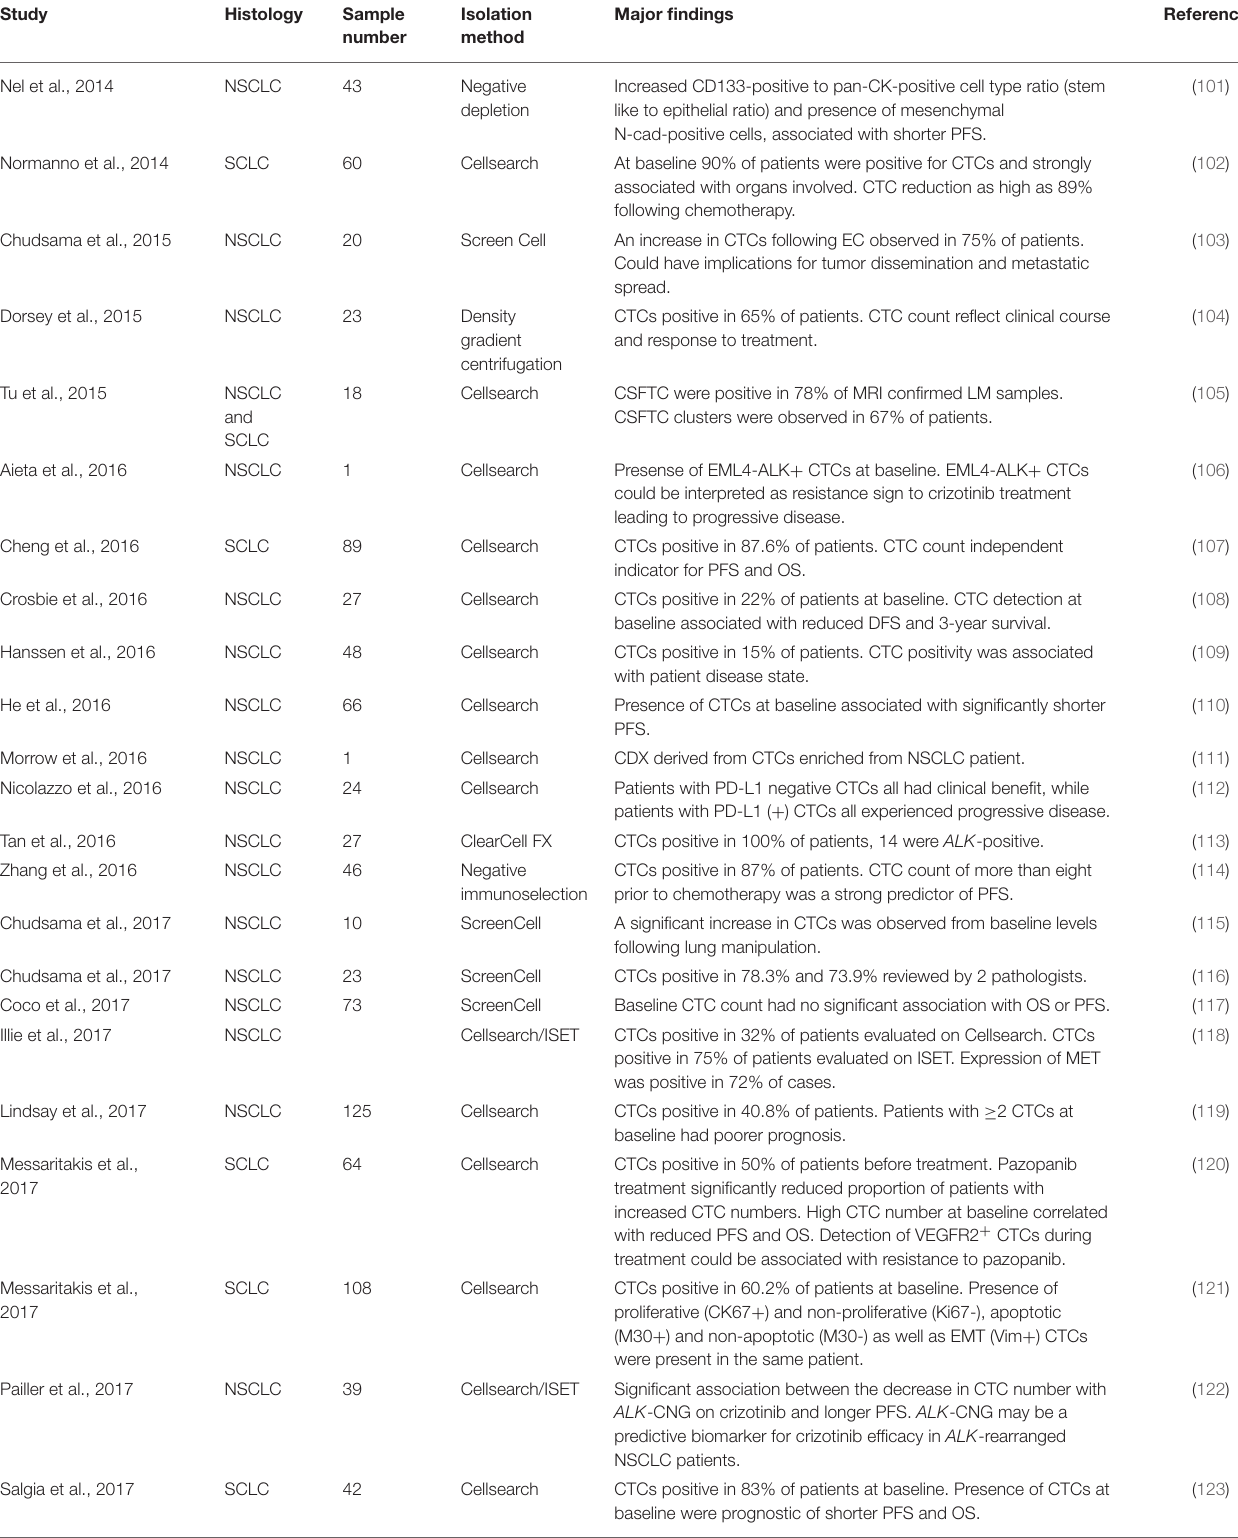
An increase in CTCs following EC observed in 75% of patients. Could have implications for tumor dissemination and metastatic spread. CTCs positive in 65% of patients. CTC count reflect clinical course and response to treatment. CSFTC were positive in 78% of MRI confirmed LM samples. CSFTC clusters were observed in 67% of patients. Presense of EML4-ALK + CTCs at baseline. EML4-ALK + CTCs could be interpreted as resistance sign to crizotinib treatment leading to progressive disease. CTCs positive in 87.6% of patients. CTC count independent indicator for PFS and OS. CTCs positive in 22% of patients at baseline. CTC detection at baseline associated with reduced DFS and 3-year survival. CTCs positive in 15% of patients. CTC positivity was associated with patient disease state. Presence of CTCs at baseline associated with significantly shorter PFS. CDX derived from CTCs enriched from NSCLC patient. Patients with PD-L1 negative CTCs all had clinical benefit, while patients with PD-L1 ( + ) CTCs all experienced progressive disease. CTCs positive in 100% of patients, 14 were ALK -positive. CTCs positive in 87% of patients. CTC count of more than eight prior to chemotherapy was a strong predictor of PFS. A significant increase in CTCs was observed from baseline levels following lung manipulation. CTCs positive in 78.3% and 73.9% reviewed by 2 pathologists. Baseline CTC count had no significant association with OS or PFS. CTCs positive in 32% of patients evaluated on Cellsearch. CTCs positive in 75% of patients evaluated on ISET. Expression of MET was positive in 72% of cases. CTCs positive in 40.8% of patients. Patients with ≥ 2 CTCs at baseline had poorer prognosis. CTCs positive in 50% of patients before treatment. Pazopanib treatment significantly reduced proportion of patients with increased CTC numbers. High CTC number at baseline correlated with reduced PFS and OS. Detection of VEGFR2 + CTCs during treatment could be associated with resistance to pazopanib. CTCs positive in 60.2% of patients at baseline. Presence of proliferative (CK67 + ) and non-proliferative (Ki67-), apoptotic (M30 + ) and non-apoptotic (M30-) as well as EMT (Vim + ) CTCs were present in the same patient. Significant association between the decrease in CTC number with ALK -CNG on crizotinib and longer PFS. ALK -CNG may be a predictive biomarker for crizotinib efficacy in ALK -rearranged NSCLC patients. CTCs positive in 83% of patients at baseline. Presence of CTCs at baseline were prognostic of shorter PFS and